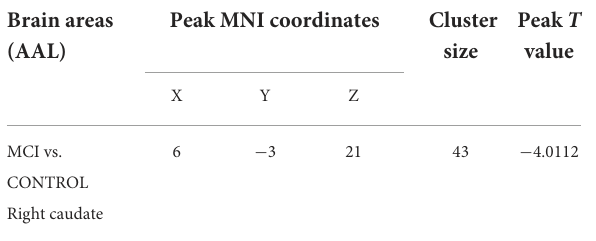
TABLE 2 ReHo difference among MCI and healthy